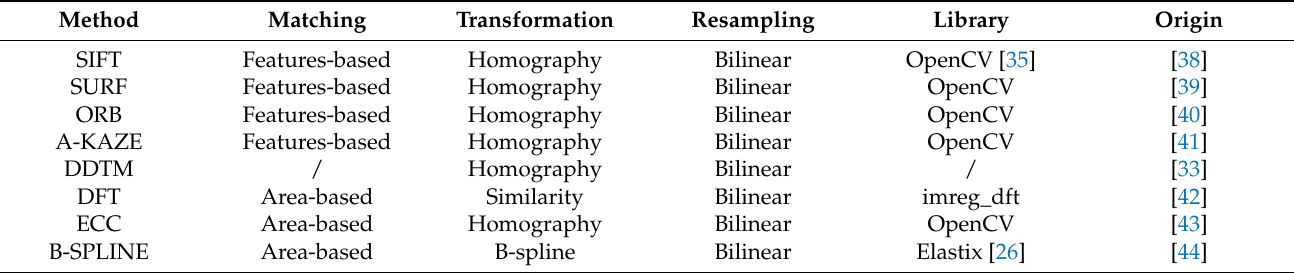
Table 1. Summary of registration methods tested in this